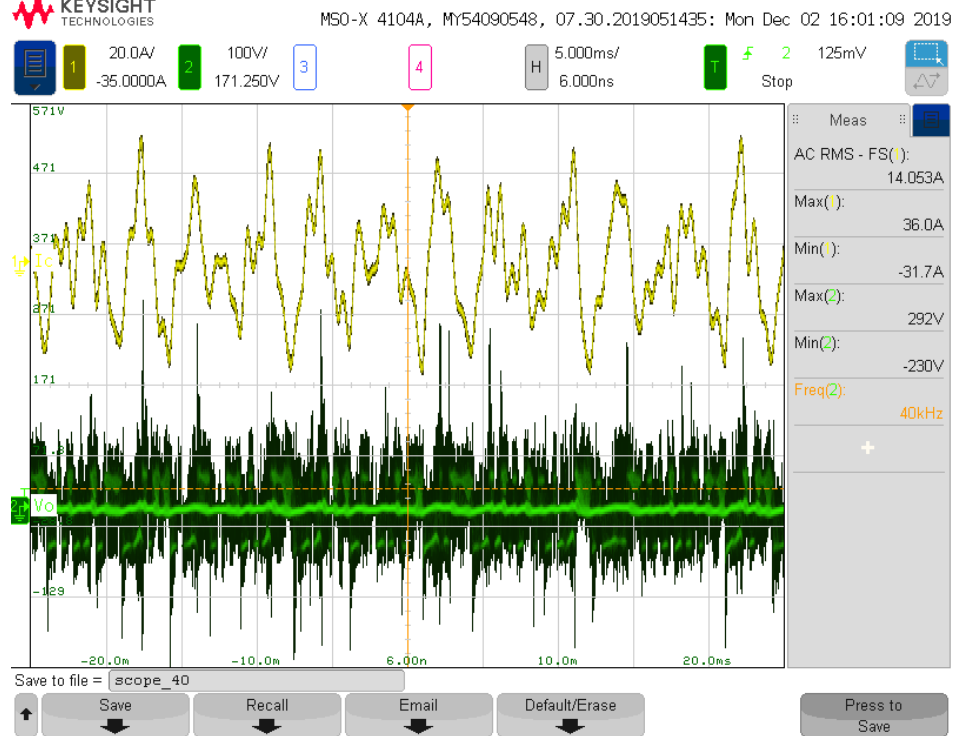
Figure 22. Compensating current I C (yellow) and output voltage v O (green). Current measurement done through Rogoswski Current Waveform Transducer CWTUM/6/B. Voltage measurement done through differential probe Pico TA042.